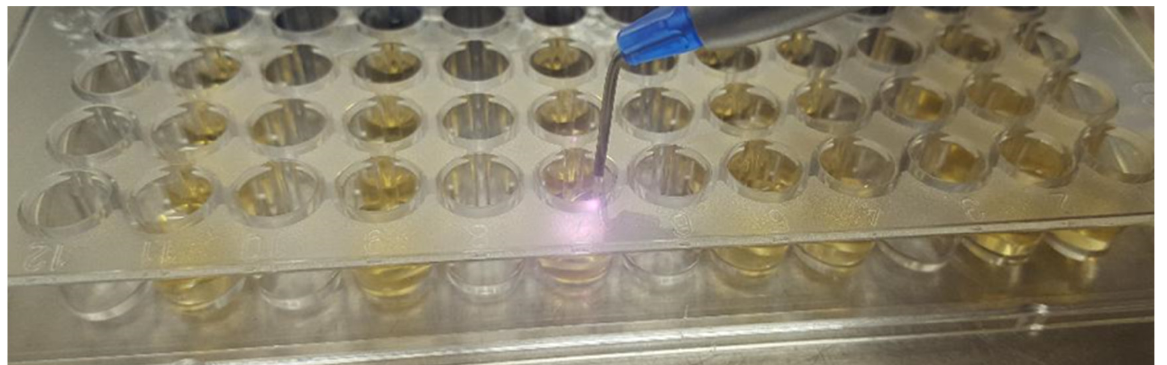
Figure 1. Application of diode laser treatment to A. actinomycetemcommitans .